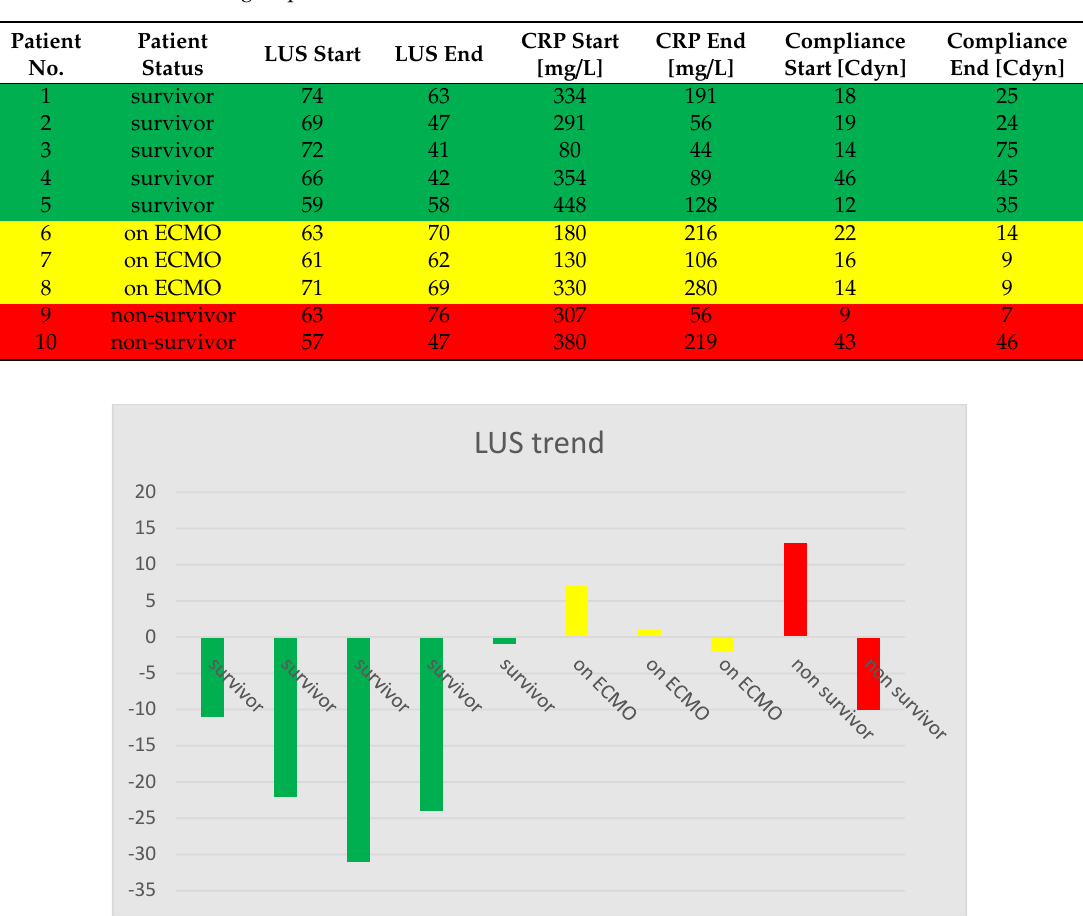
Figure 6. Box plot of the LUS trend calculated from the LUS scores of the first and last day of scan for each patient.